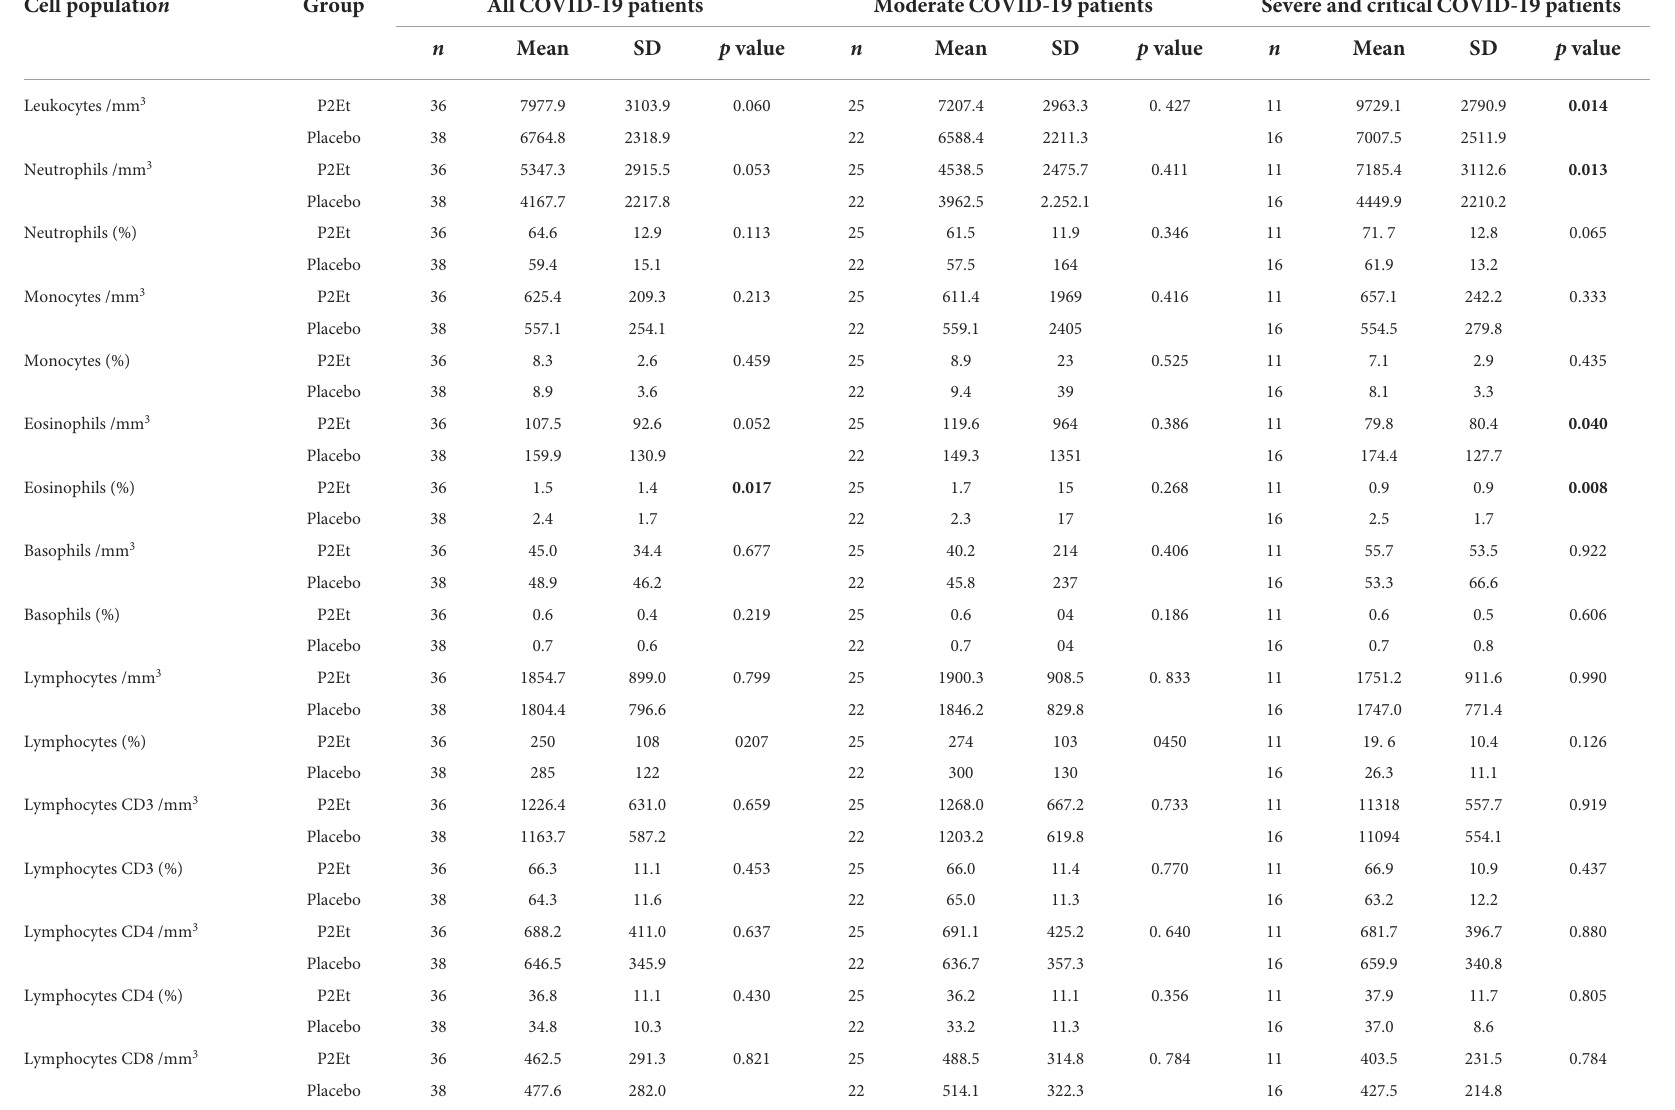
TABLE 4 Differences between cell populations in the two arms and analyzed in moderate vs. severe or critical patients. Cell populatio